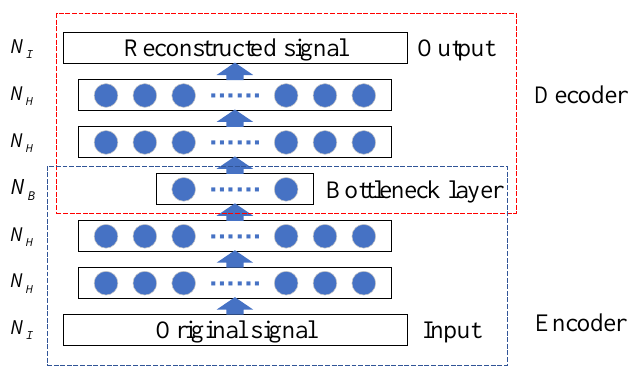
Figure 2. Block diagram of the auto-encoder network. Table 1. Architecture of the deep auto-encoder network. Dense refers to fully connected layers. The numbers 576, 500, and 40 are the numbers of neurons. BN refers to batch normalization layer. Mish and sigmoid are activation